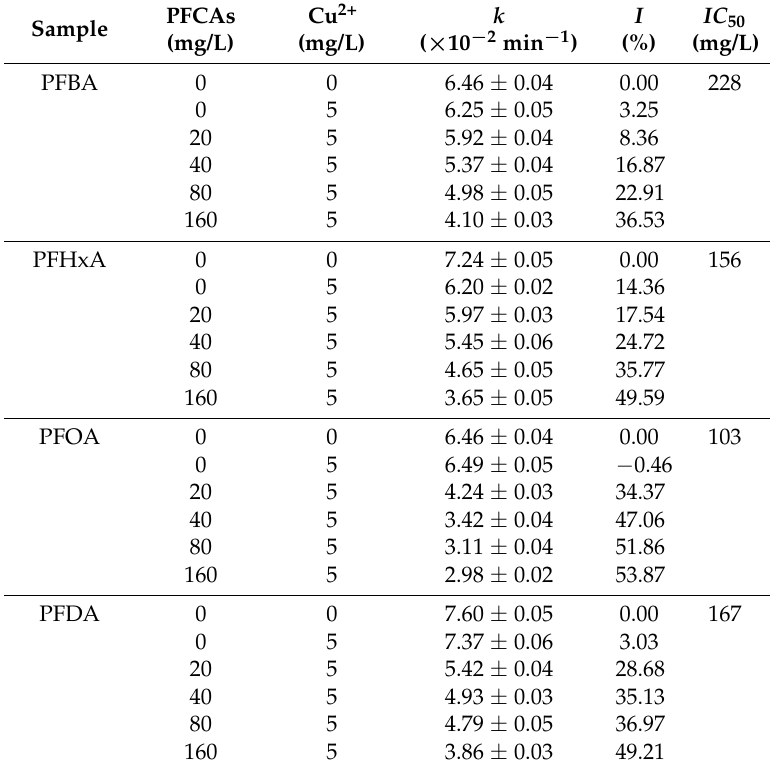
Table 2. Effect of combined exposure to PFCAs and copper in k , I , and IC 50